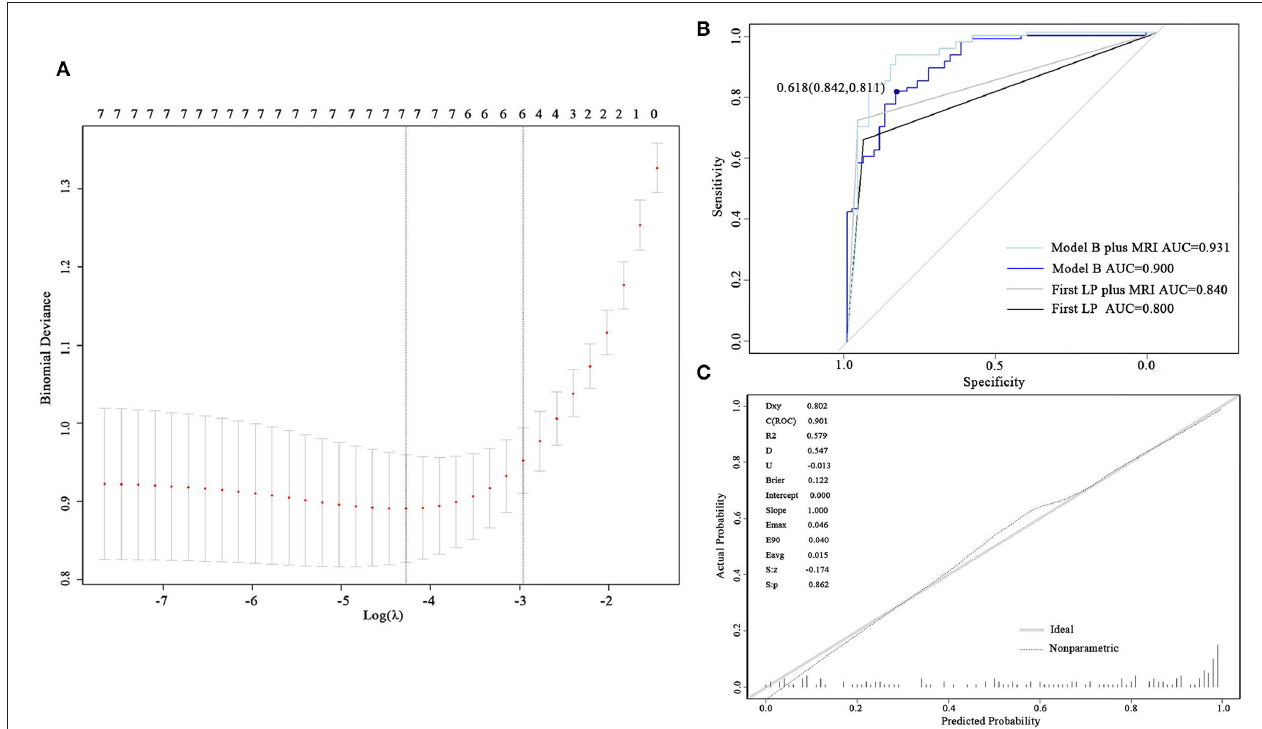
FIGURE 3 | Development and validation of model B. (A) Cross-validation plot for the penalty term. Two solid lines corresponded to seven and six variables when λ was minimum and minimum within one SE, respectively. (B) ROC curves of model B and the first LP. The AUC was 0.901 for model B and 0.800 for the first lumber puncture. (C) The calibrated curve for model B. The gray solid line represents the actual probability, and the dotted line represents the prediction probability of model B. AUC, area under the curve; ROC, receiver operating characteristic; LP, lumber